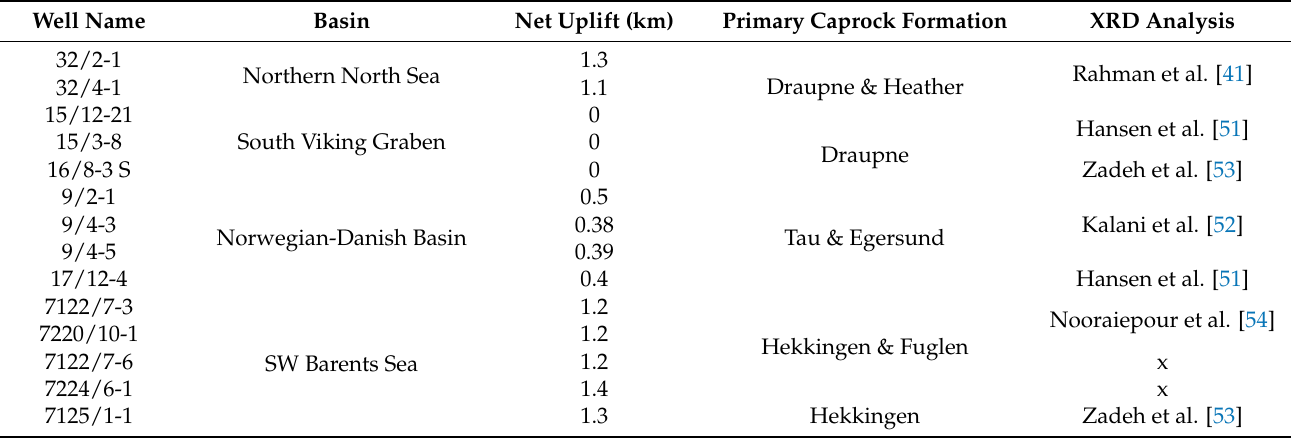
Table 1. An overview of the studied wells shows the maximum exhumation differences within different basins. The source of XRD mineralogy for different primary caprocks is also illustrated. Please note that two wells out of 14 do not have XRD mineralogy data (follow the ‘x’ sign in the table)